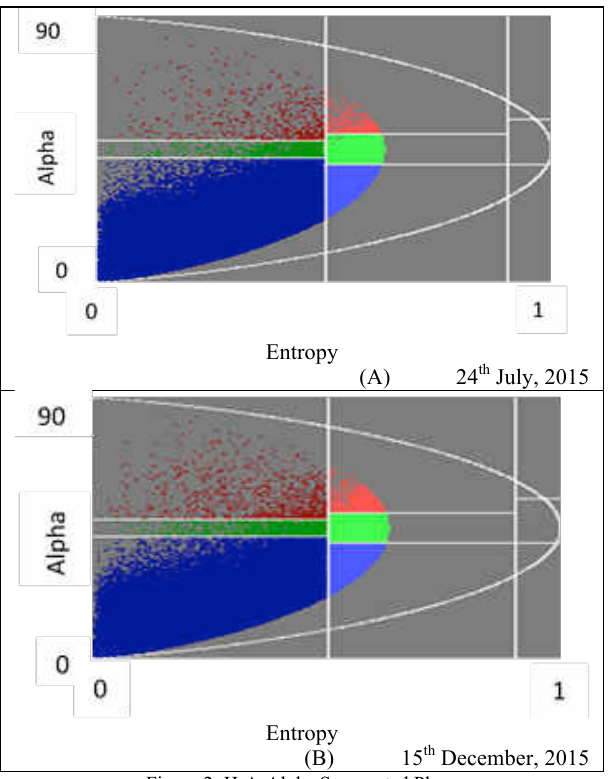
Surface scattering in the study area are represented by the blue portion of the graph with alpha values less than 40 degrees. Volume scattering from features are shown in the green part where alpha varies from 40 to 45 degrees. Areas with alpha values more than 45 degrees have multiple scattering and are shown in red. The inputs from entropy, anisotropy and alpha were used for Wishart H-A- α classification of both the images. The overall classification accuracies significantly increased to 79% for the monsoon month and 81% for the winter